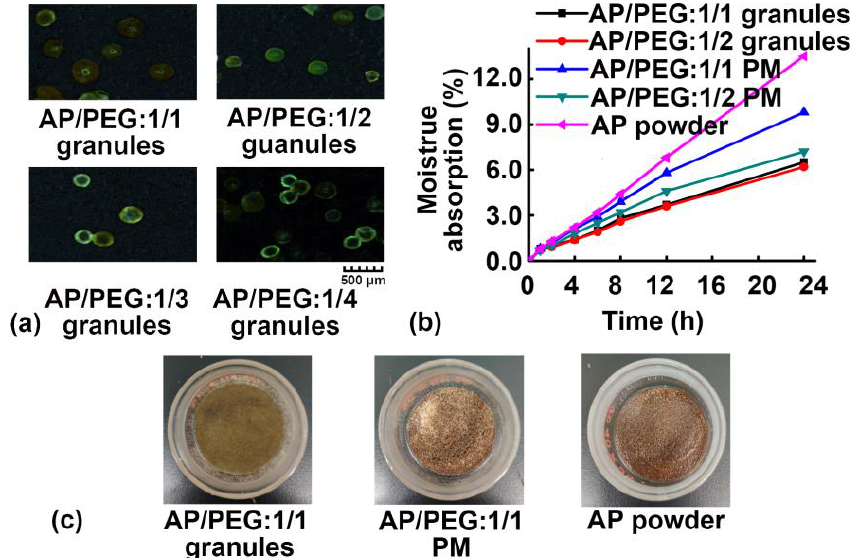
Figure 7. ( a ) Typical morphology of astragalus polysaccharide (AP)/polyethylene glycol (PEG) granules with different ratios at 0 h observed by a stereomicroscope. ( b ) Moisture absorption curves of granules produced via melt centrifugal atomization (MCA), physical mixture (PM) of AP and PEG, and AP during 24 h; and ( c ) their typical appearance at 24 h.